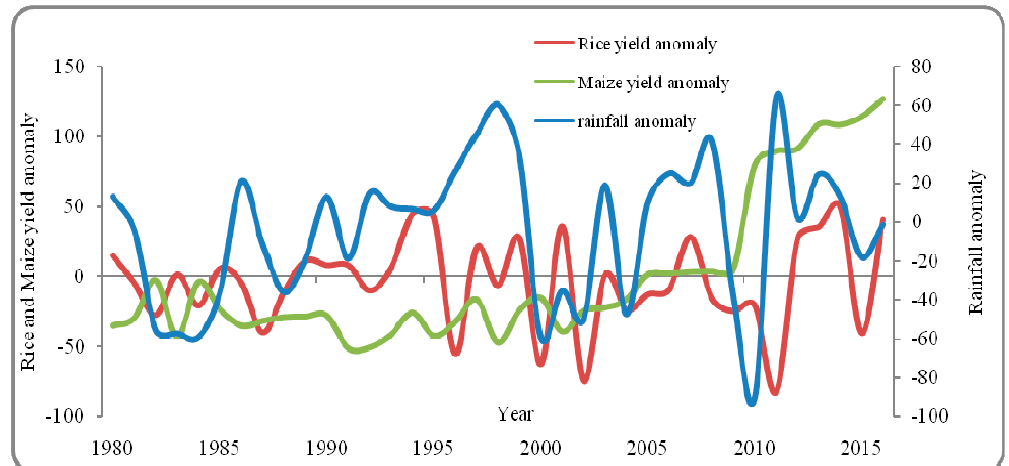
Figure 2. Rice and maize yield anomaly and seasonal rainfall anomaly (1980 – 2017).